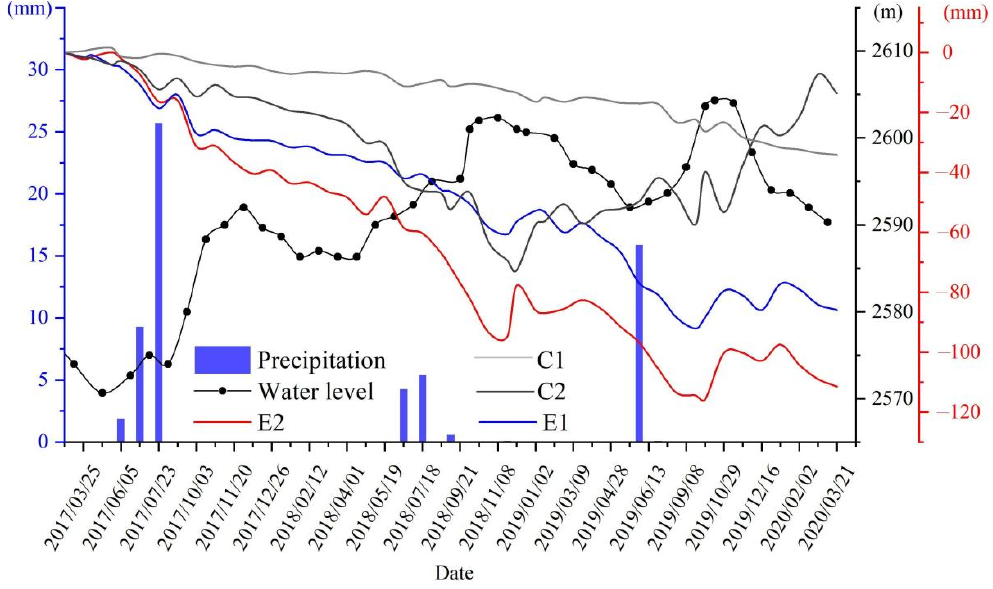
Figure 12. Time series of precipitation, water level, and deformation for Chana landslide.